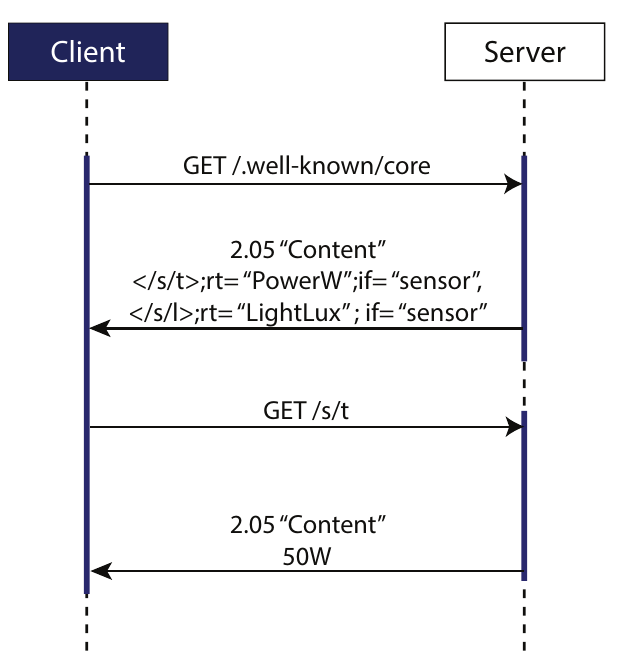
Figure 5. CoAP Resource